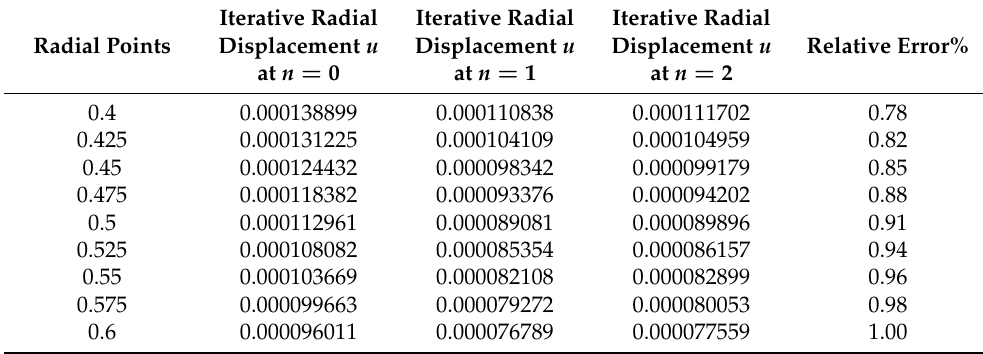
Table 4. Comparison of radial displacement u n in FGM cylinder at n = 0, n = 1 and n = 2 iterations under internal pressure, P a = 50 MPa and external pressure, P b = 20 MPa.